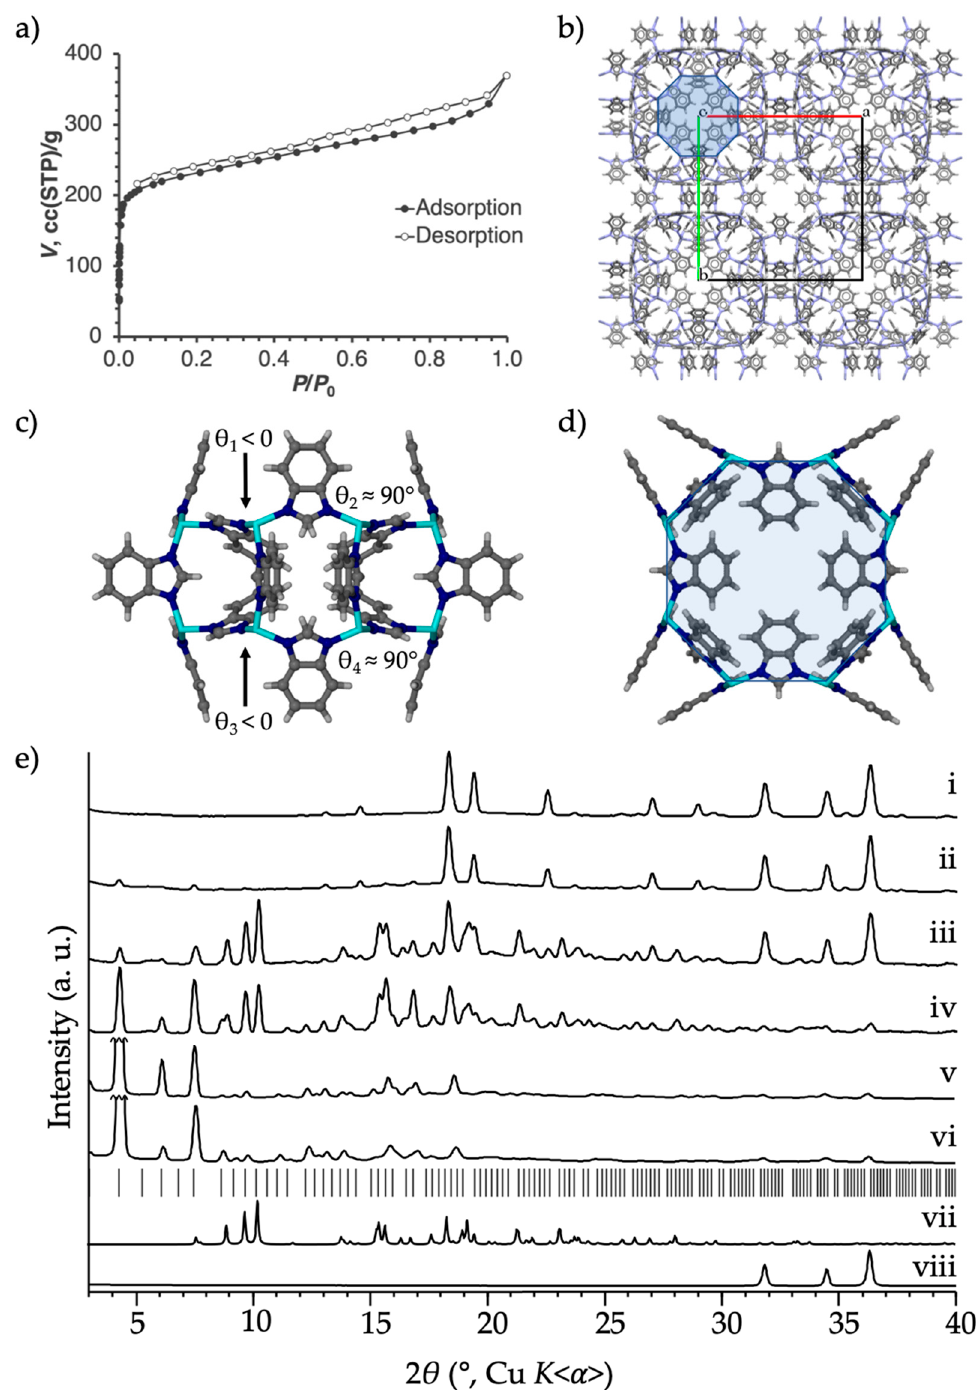
Figure 4. Synthesis and characterization of RHO-Zn BIm 2 (ZIF-11). ( a ) The 77 K low pressure N 2 isotherm. ( b ) The crystal structure of RHO-Zn BIm 2 (CSD code VEJZOA) as viewed down the [001] axis (the d8r motif is shaded blue). ( c , d ) Side and top views of the d8r motif of RHO-Zn BIm 2 (shaded blue). ( e ) PXRD patterns of the non-templated LAG-aging reaction of ZnO and H BIm after (i) 3 days, and (ii) 12 days; the MeMeCH 2 templated LAG-aging reaction of ZnO and H BIm after (iii) 3 days, (iv) 12 days, (v) the washed RHO-Zn BIm 2 (ZIF-11) final product after 45 days, and (vi) the same material after activation and 77 K low pressure N 2 sorption analysis. (vii) Simulated PXRD pattern of MeMeCH 2 ⋅ 2DEF. (viii) PXRD pattern of nanoparticulate ZnO. Tick marks denote predicted peak positions of RHO-Zn BIm 2 (ZIF-11, VEJZOA).